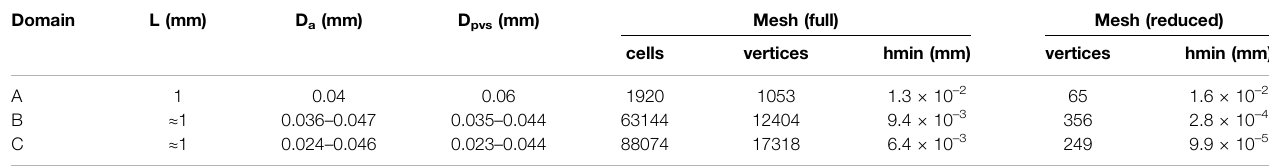
TABLE 1 | Geometrical or numerical PVS domain characteristics for domains A, B, C.